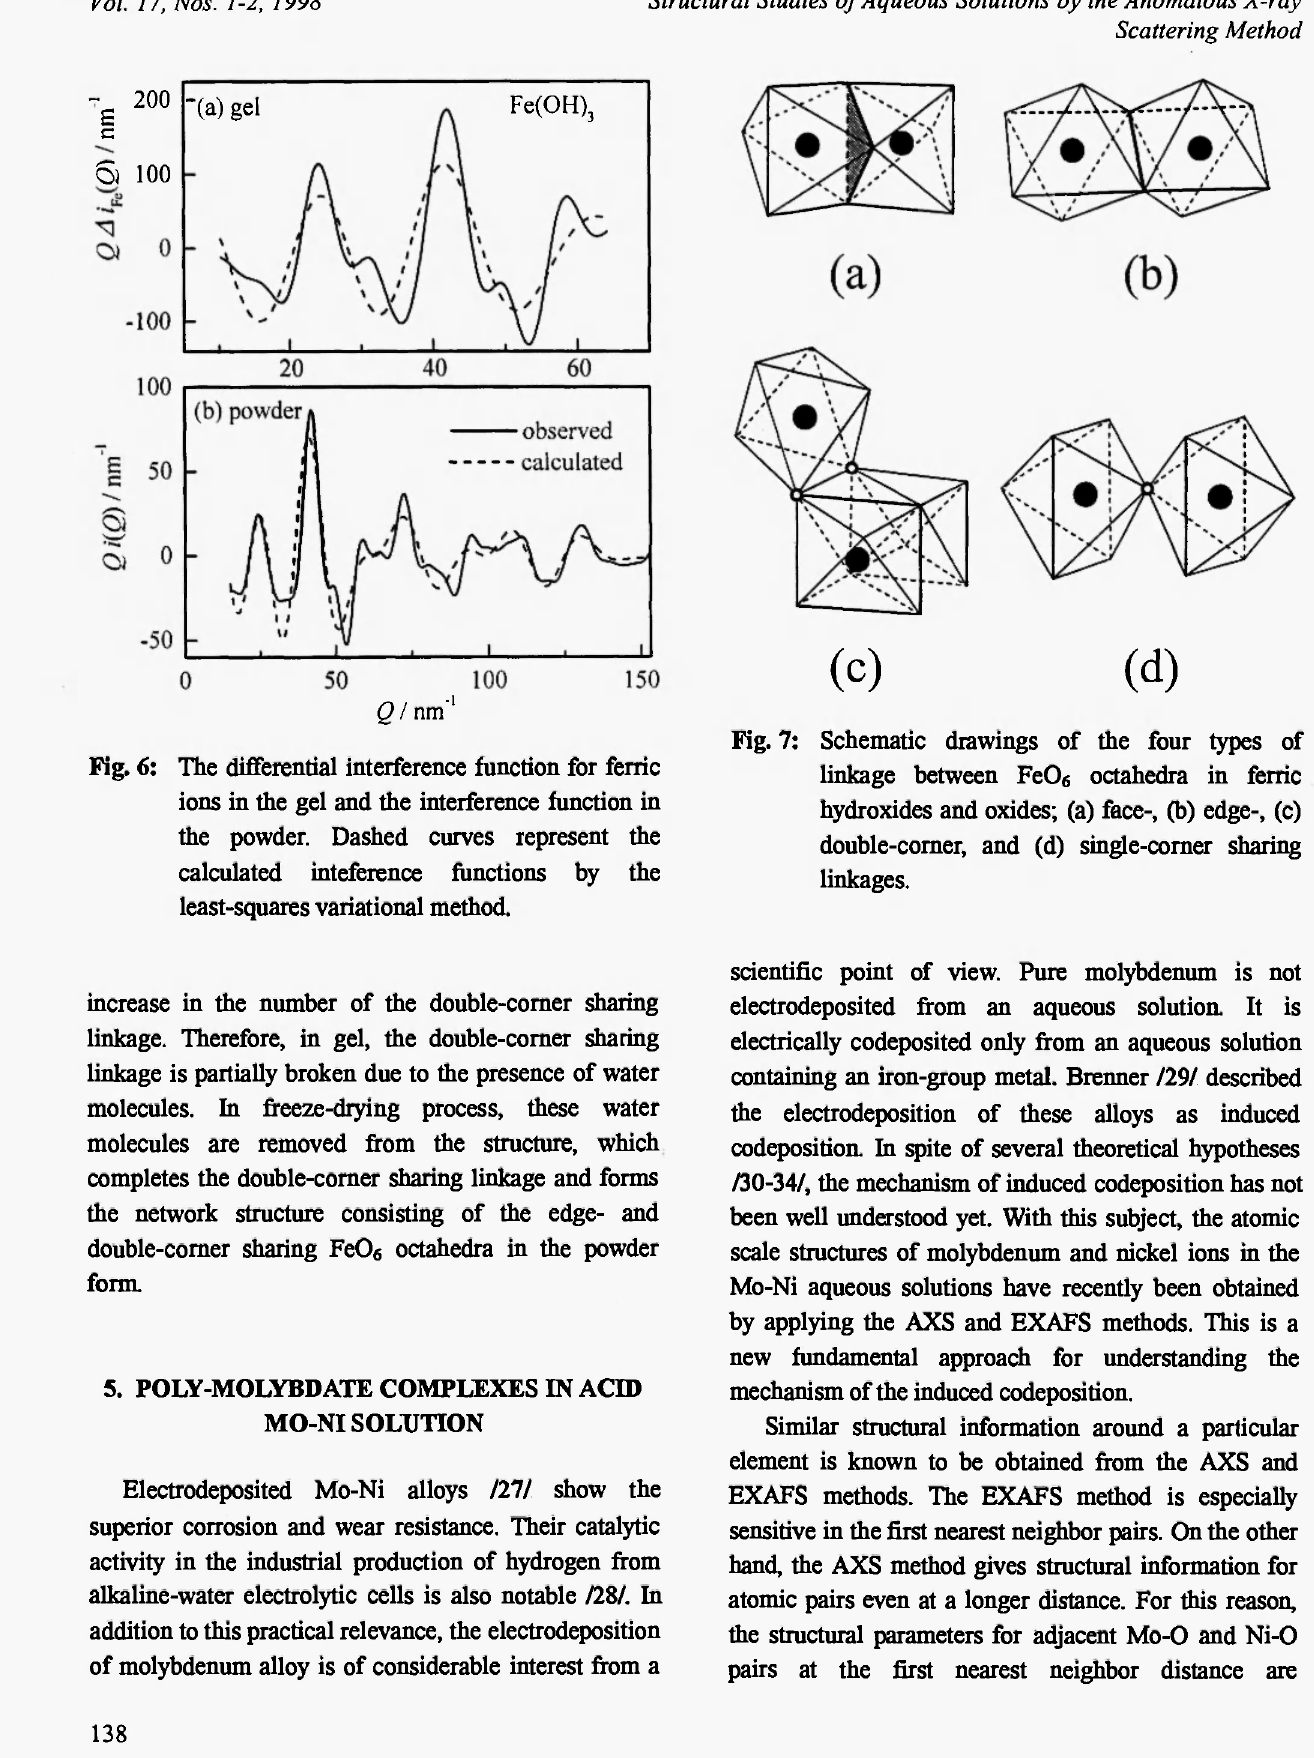
Fig. 7: Schematic drawings of the four types of linkage between Fe0 octahedra in ferric 6 hydroxides and oxides; (a) face-, (b) edge-, (c) double-corner, and (d) single-corner sharing